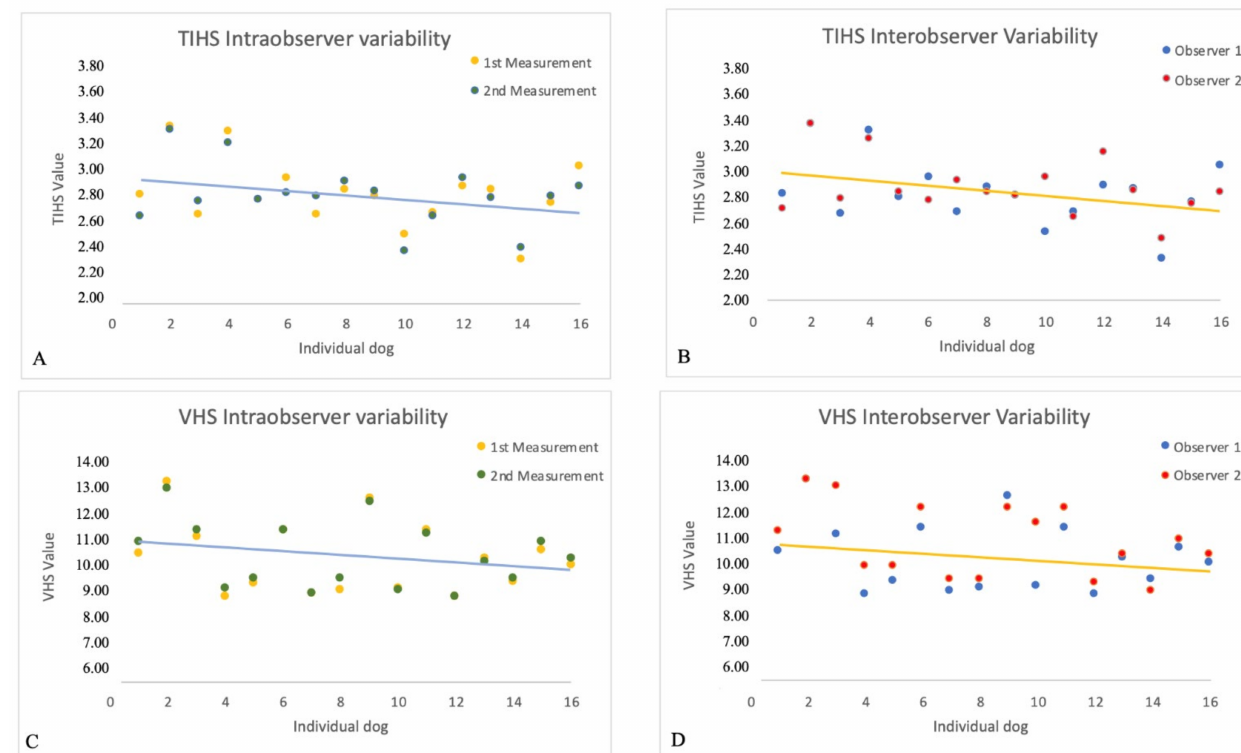
Figure 4. Scatterplots for intra- and interobserver variability on TIHS ( A , B ) and VHS ( C , D ) values measured on right lateral thoracic radiographs from 16 randomly selected dogs. The solid line represents the tendency line for the variable